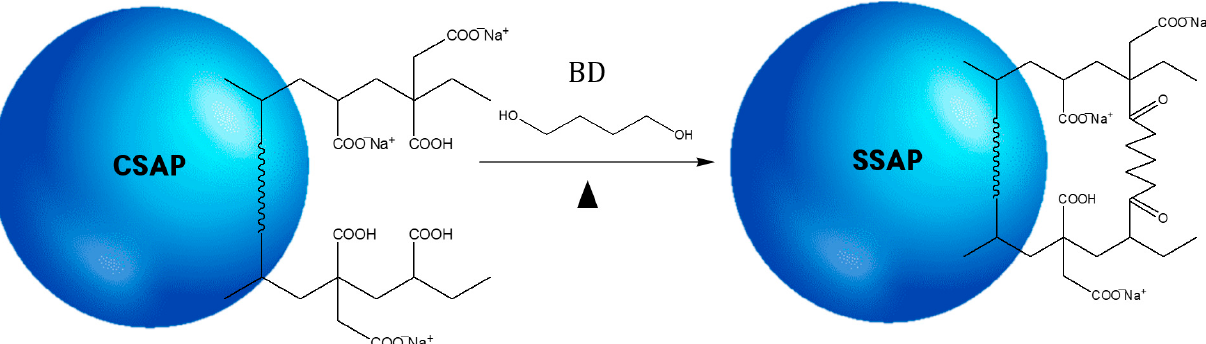
Figure 2. FT-IR spectra of IA, AA, and CSAP.